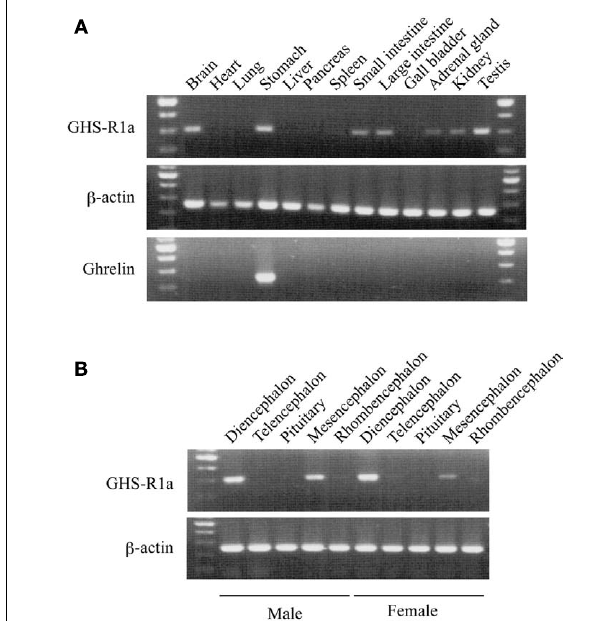
FIGURE 6 | Growth hormone secretagogue-receptor 1a mRNA expression in bullfrog tissues. (A) Body tissues of a male frog. Upper, middle and lower columns indicate GHS-R1a, β -actin and ghrelin, respectively. (B) Five parts of brain region.The former five tissues are obtained from a male and the latter five are from a female. Upper and lower columns indicate the result of GHS-R1a and β -actin, respectively. All gel views are obtained by 35 cycles of PCR.